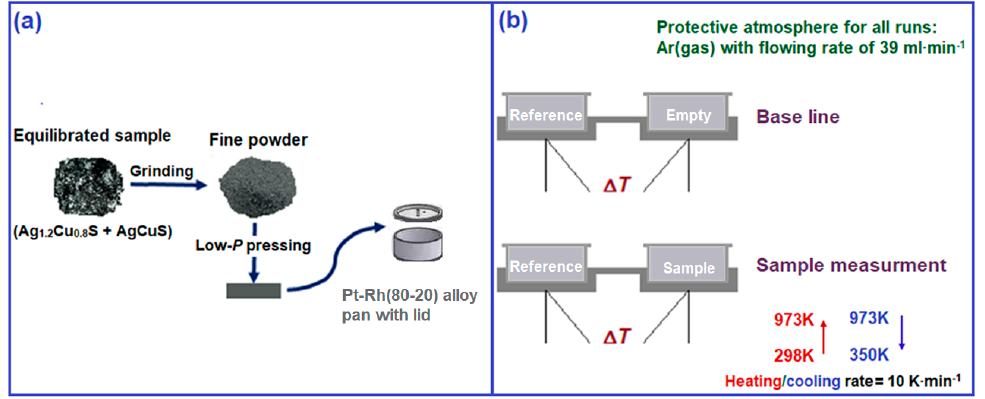
Figure 2. ( a ) Sample preparation for the differential scanning calorimetry-thermogravimetric analysis (DSC-TGA) measurements, and ( b ) the two-step experimental procedure in the DSC-TGA measurements.